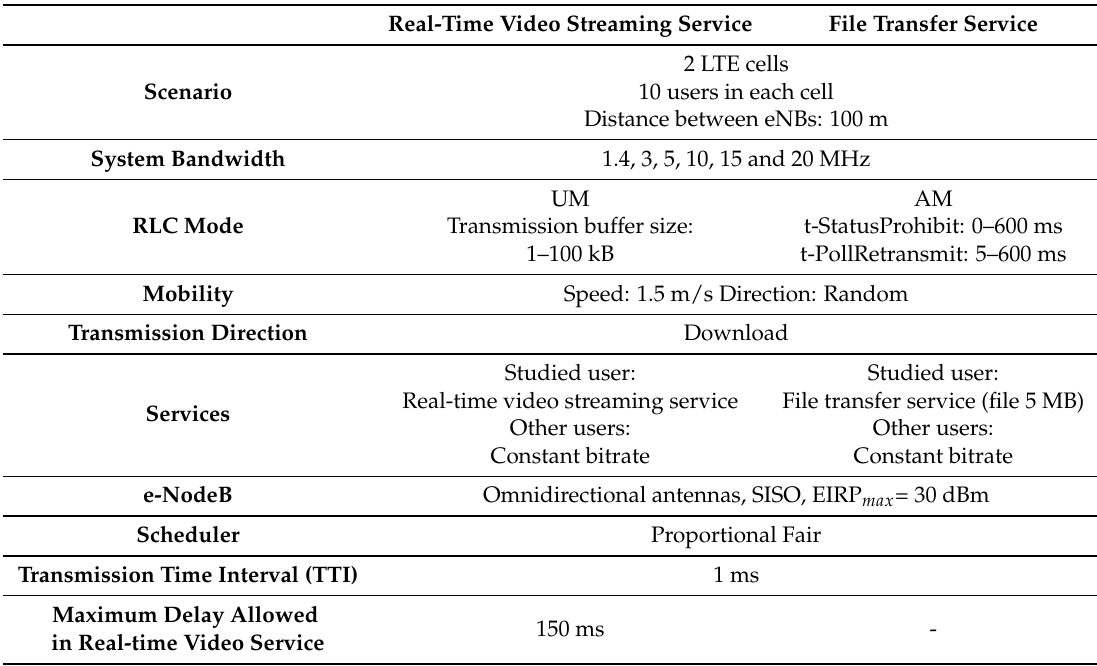
Table 1. Simulation scenario and main configuration